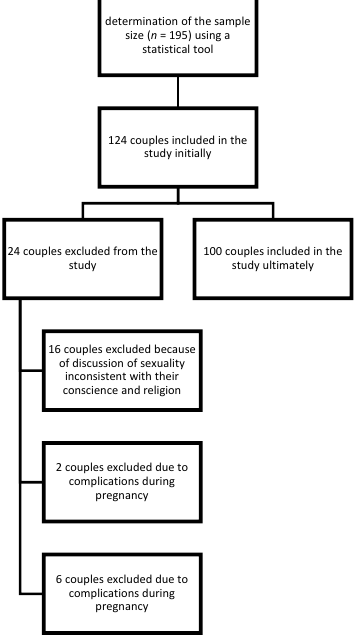
Figure 1. Sample selection process.